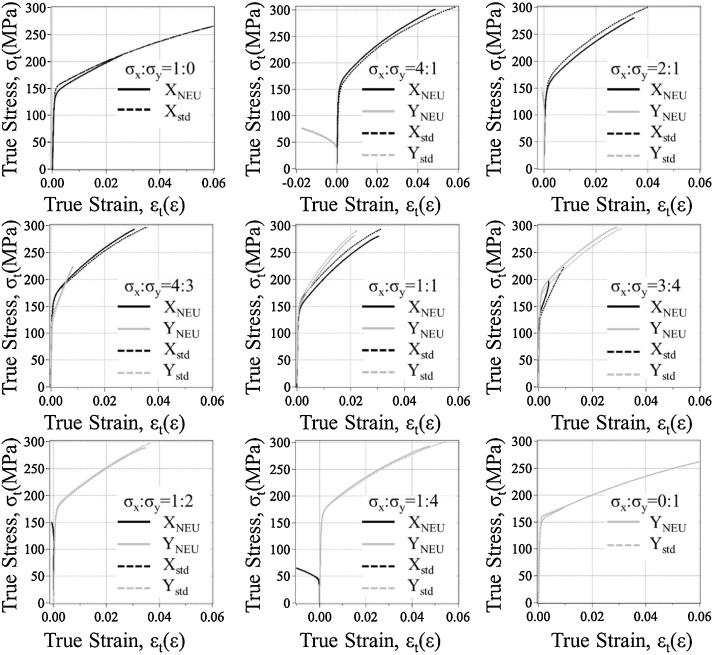
True stress – true strain diagrams obtained by tensile tests under nine biaxial stress ratios. XNEU, YNEU, Xstd, Ystd are stresses in the X and Y directions obtained with the BTM-NEU and the BTM-std, respectively.